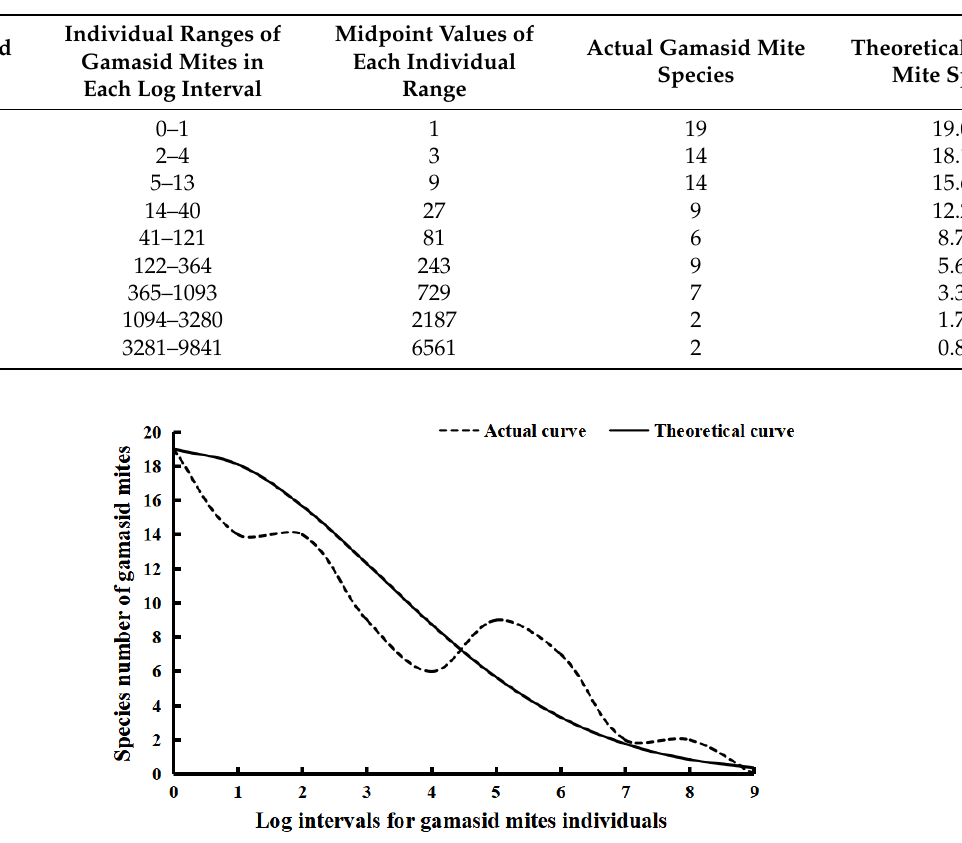
Figure 4. Theoretical curve fitting of species abundance distribution of gamasid mite community in Three Parallel Rivers Area in northwest Yunnan of China (2001 – 2015).